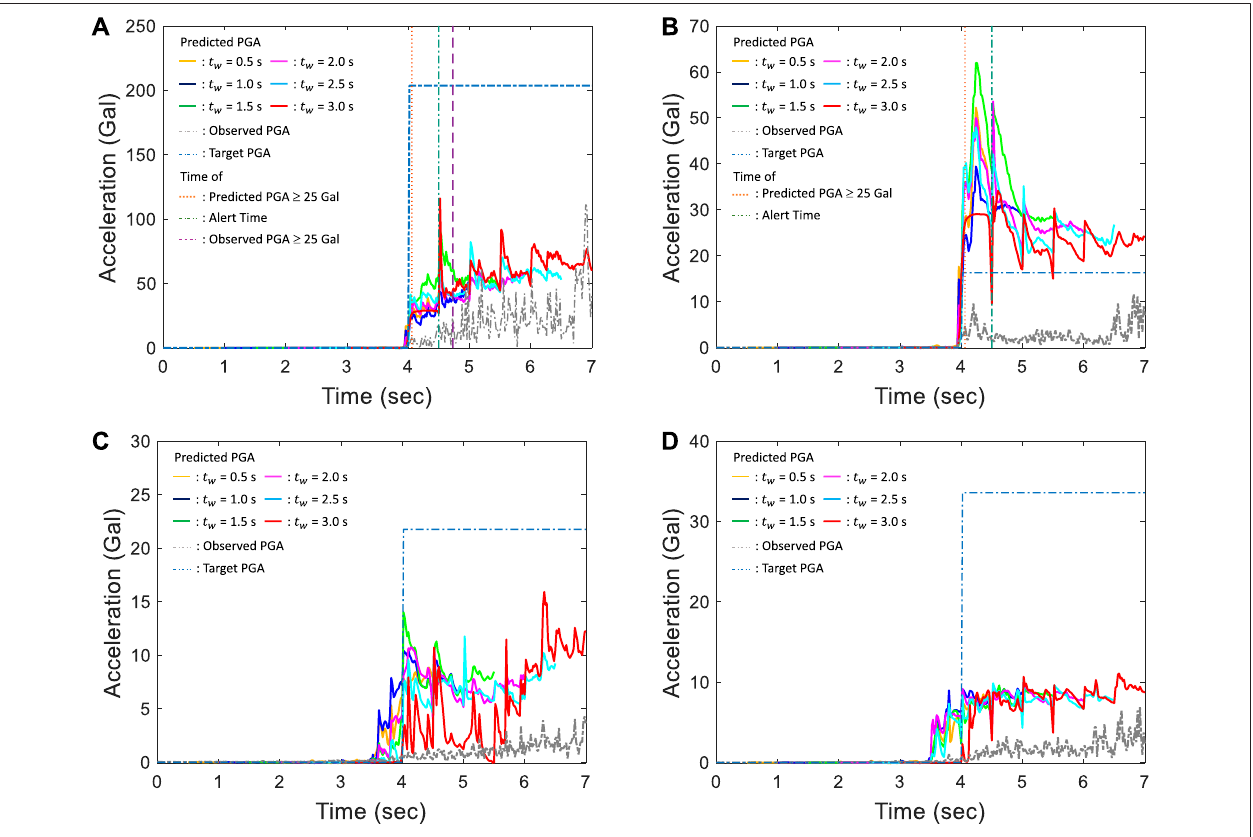
FIGURE 8 | Observed PGA time histories, predicted PGA time histories of different windows, and target PGA time histories of a typical (A) TP, (B) FP, (C) TN, and (D) FN case.